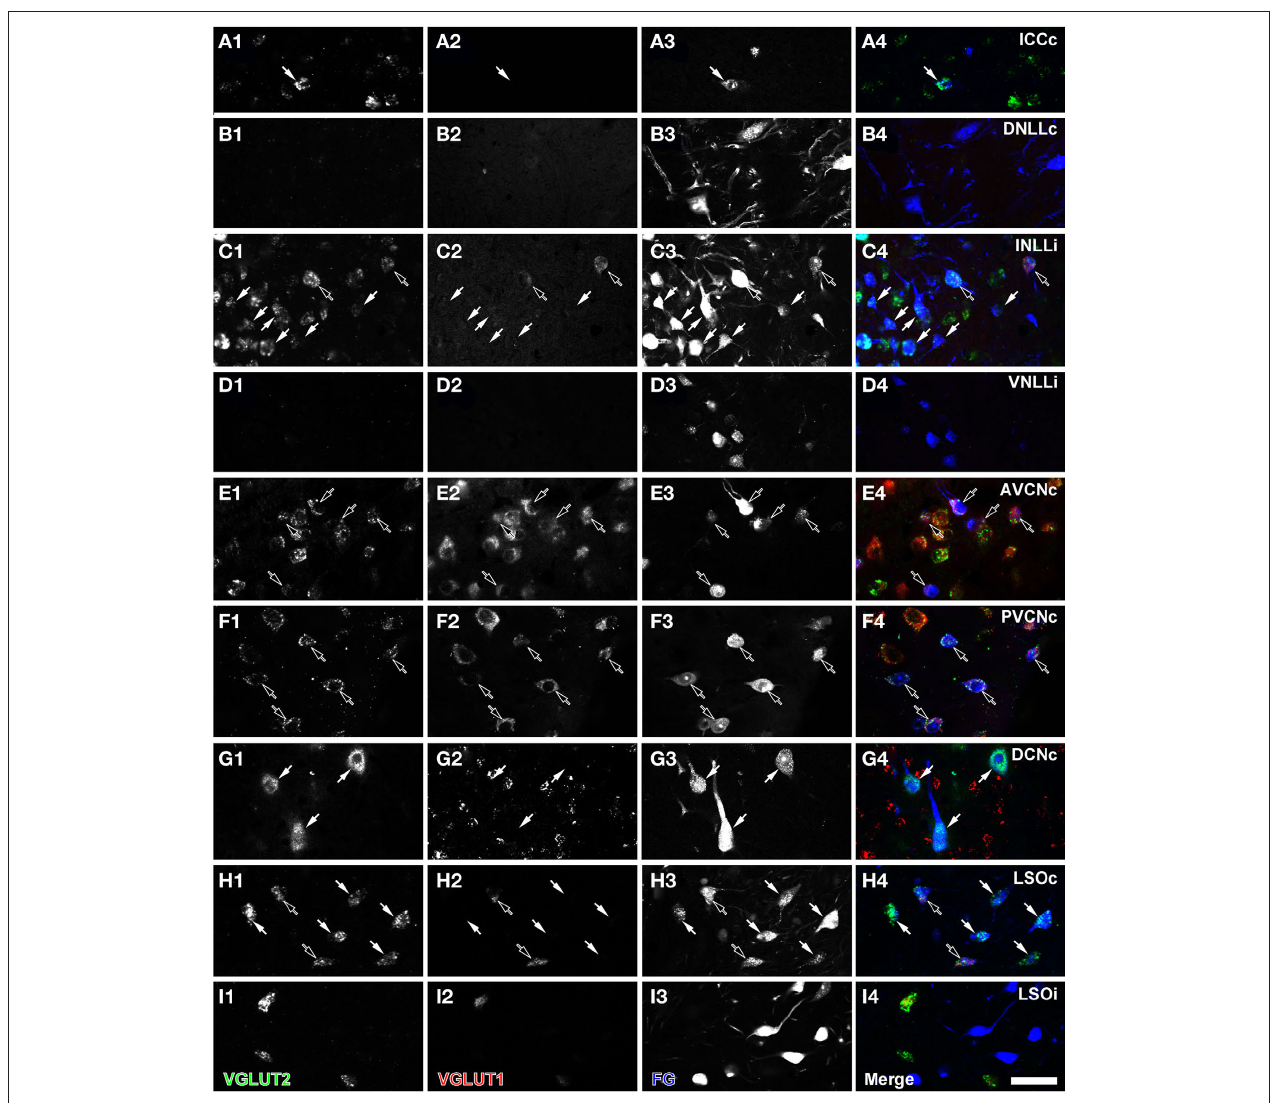
Figure 3 | Fluorescent micrographs of retrogradely labeled cells in the iC (A), NLL (B–D), CNC (e–g), and SOC (H–Q). Some retrogradely labeled cells expressed only VGLUT2 (white arrows) or both VGLUT1 and VGLUT2 (black arrows). The “ c ” and “ i ” after the abbreviation of the nuclei mean contralateral and ipsilateral to the injection site. Green: VGLUT2; red: VGLUT1; blue: FG. Scale bar: 50